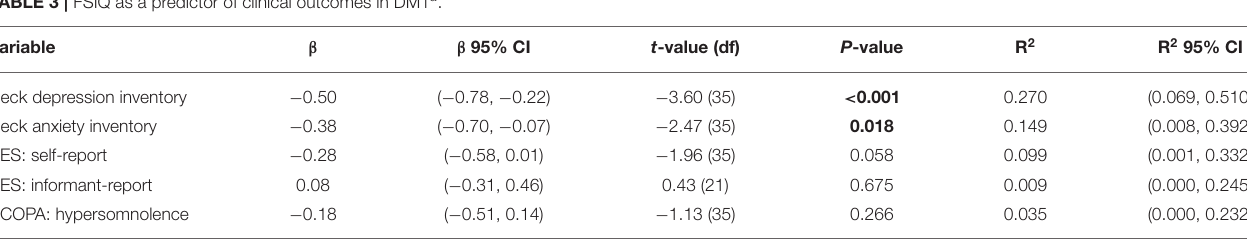
TABLE 3 | FSIQ as a predictor of clinical outcomes in DM1 a